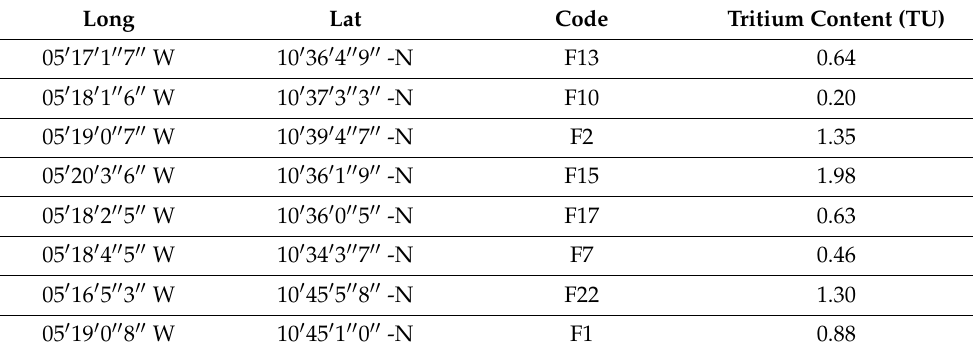
Table 3. Tritium contents in groundwater in the basin.